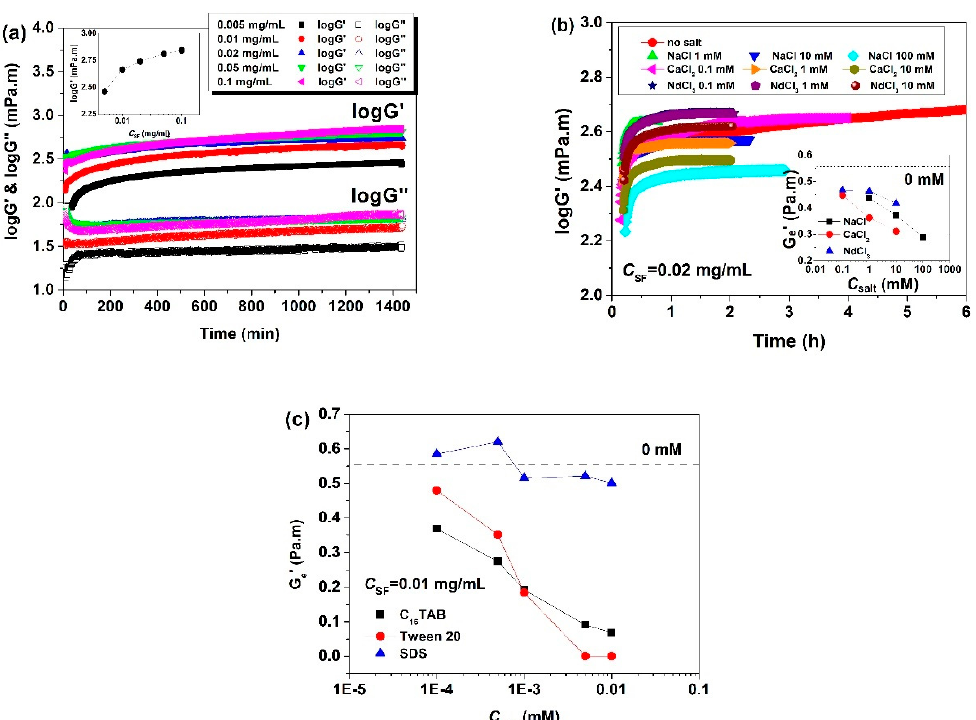
Figure 5. Influences of the solution conditions on the (equilibrium) surface shear moduli of adsorbed SF layers at the air/water interface: ( a ) influences of C SF ; ( b ) influences of salts; ( c ) influences of surfactants. G’ in the inset plot of ( a ) is obtained after 24 h, and the dashed horizontal line in the inset plots of ( b ) and ( c ) indicates the value for a pure SF solution without any added surfactant (taken from [34,36,37]).